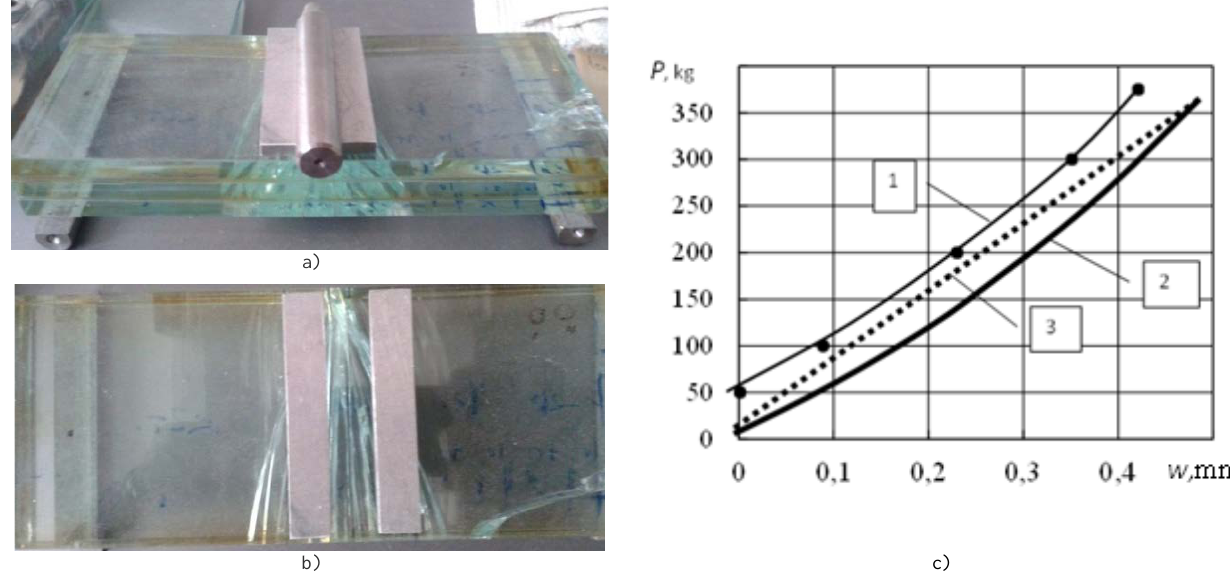
Fig. 6 Loading device and fracture character of laminated specimen a),fracture source in the edge of bottom glass layer b) and loading diagram c) for triple layer specimen under three-point bending.